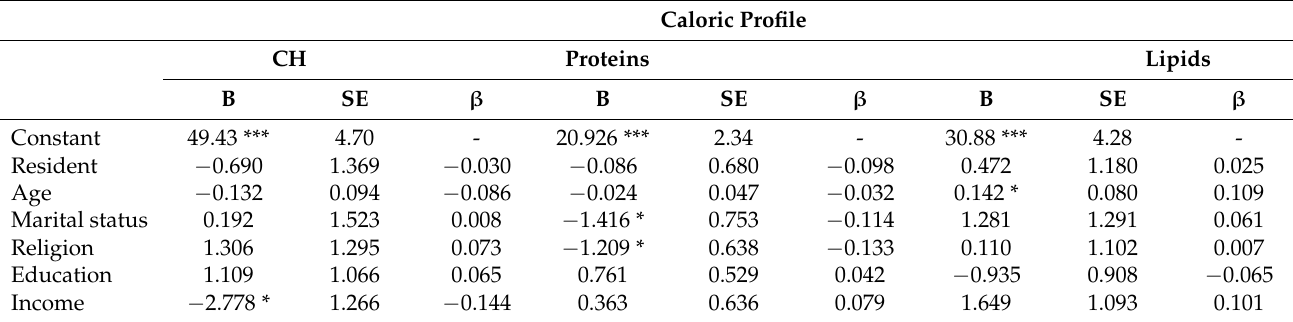
Table 7. Relationship between caloric profile and sociodemographic